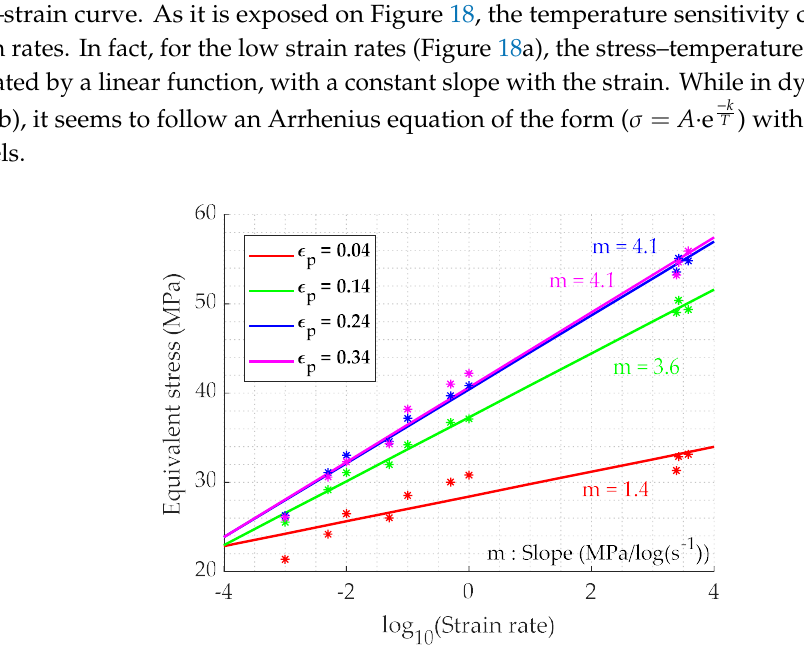
Figure 17. True stress in function of strain rates, at room temperature, for different values of the true plastic strain.